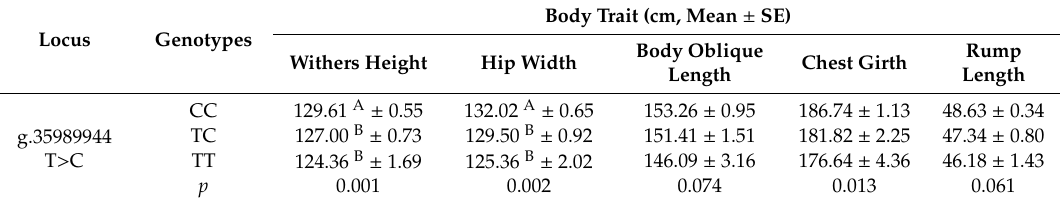
Table 4. Association between the KCNJ12 variation and cattle stature in Jin’nan (JN) cattle.